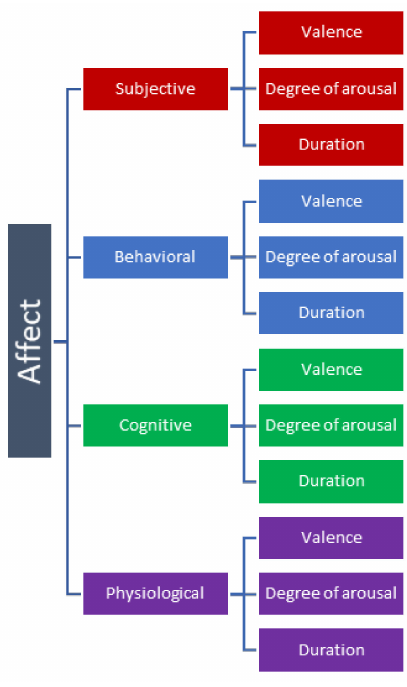
Figure 1. The framework of affective